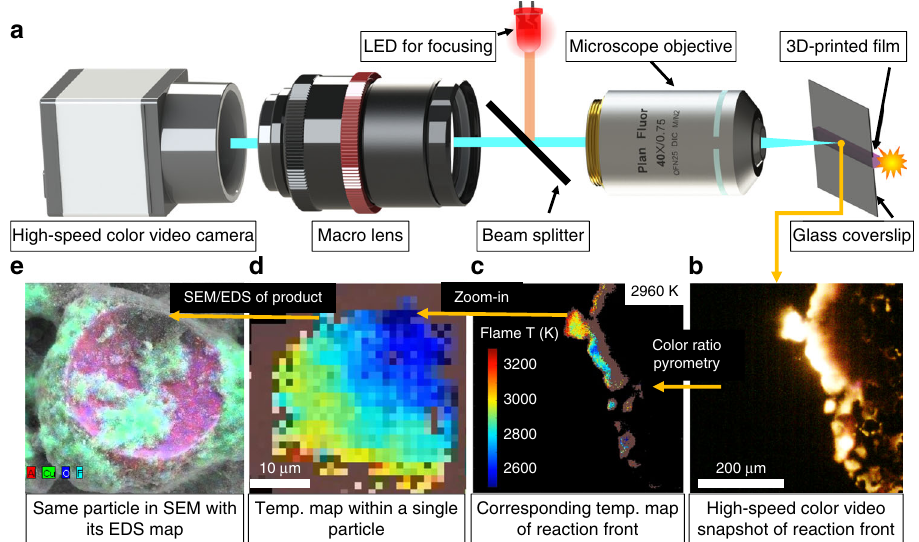
Fig. 1 Imaging setup and example outputs. a Schematic showing high-speed microscope imaging of three-dimensionally (3D) printed reactive materials. Read from right to left: b High-speed color video snapshot of reaction front; c corresponding temperature map of reaction front; d temperature map within a single particle; and e the same particle in scanning electron microscopy (SEM) with its energy-dispersive spectrometry (EDS) map. CAD fi le of microscope objective courtesy of